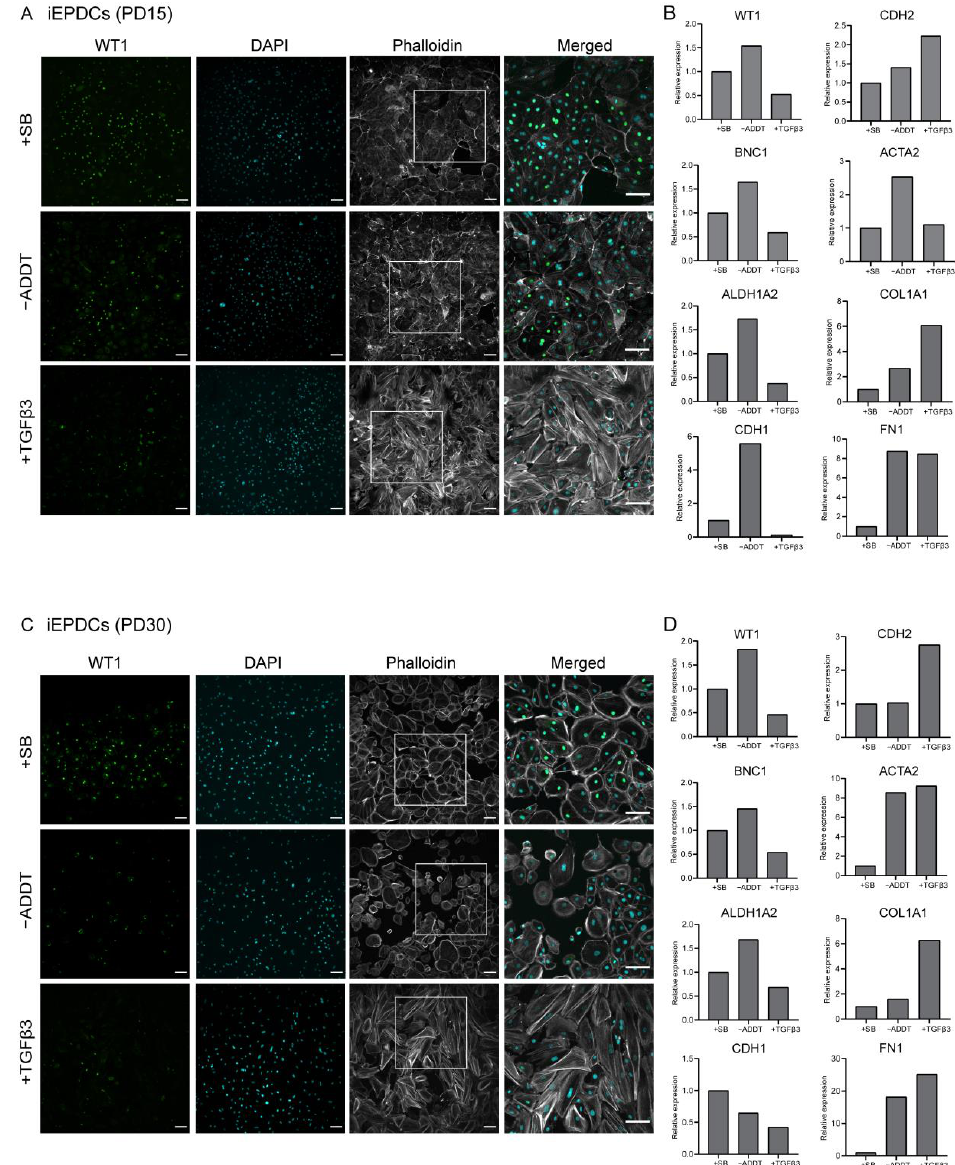
Figure 3. iEPDCs undergo EMT and show a mesenchymal phenotype upon TGF β 3 stimulation. ( A ). Immunostaining of iEPDCs of PD15 cultured in Dox-free medium containing SB (10 µ M), TGF β 3 (1 ng/mL), or neither of the two. The iEPDCs show similar morphological characteristics and WT1 expression profiles as equally treated primary human EPDCs of PD3. ( B ) Assessment by RT-qPCR of epithelial and mesenchymal marker gene expression in iEPDCs of PD15 following different treatments. ( C ) Immunostaining of iEPDCs of PD30 cultured in Dox-free medium containing SB, TGF β 3, or neither of the two. The iEPDCs show similar morphological characteristics and WT1 expression profiles as equally treated primary human EPDCs of PD3. ( D ) . Assessment by RT-qPCR of epithelial and mesenchymal marker gene expression in iEPDCs of PD30 following different treatments. Technical replicates: 3, biological replicates: 1. Scale bar = 100 µ m. − ADDT = no